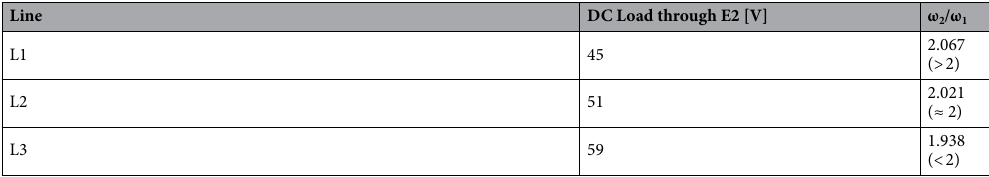
Table 1. 1st and 2nd modes of vibration ratios close to the 2:1. Line